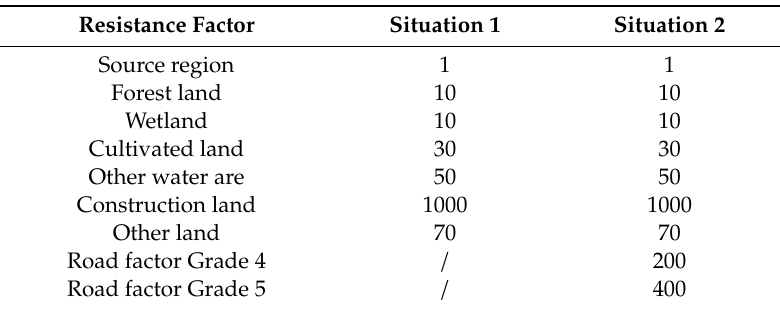
Table 6. Assignment of di ff erent situational resistance